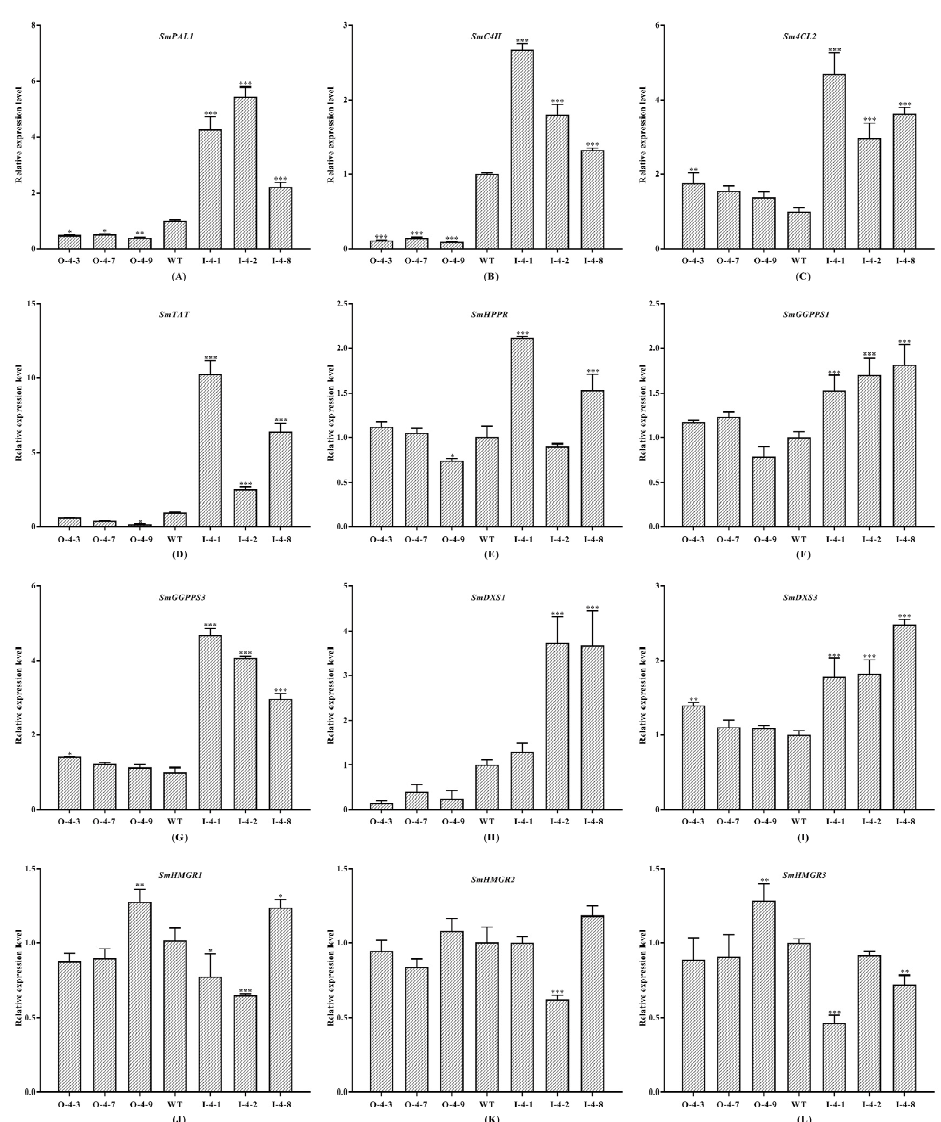
Figure 5. The relative expression level of the key enzyme genes in the salvianolic acid and tanshinone biosynthetic pathways. ( A ), ( B ), ( C ), ( D ) and ( E ) represent the relative expression level of SmPAL1 , SmC4H , Sm4CL2 , SmTAT , and SmHPPR in the salvianolic biosynthetic pathway, respectively. ( F ), ( G ), ( H ), ( I ), ( J ), ( K ), and ( L ) represent the relative expression level of SmGGPPS1 , SmGGPPS3 , SmDXS1 , SmDXS3 , SmHMGR1 , SmHMGR2 , and SmHMGR3 in the tanshinone biosynthetic pathway, respectively. (* p < 0.5, ** p < 0.01, *** p < 0.001).